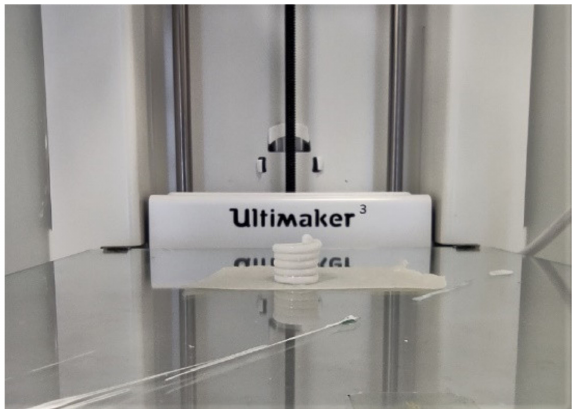
Figure 2. Photo of DDS immediately after